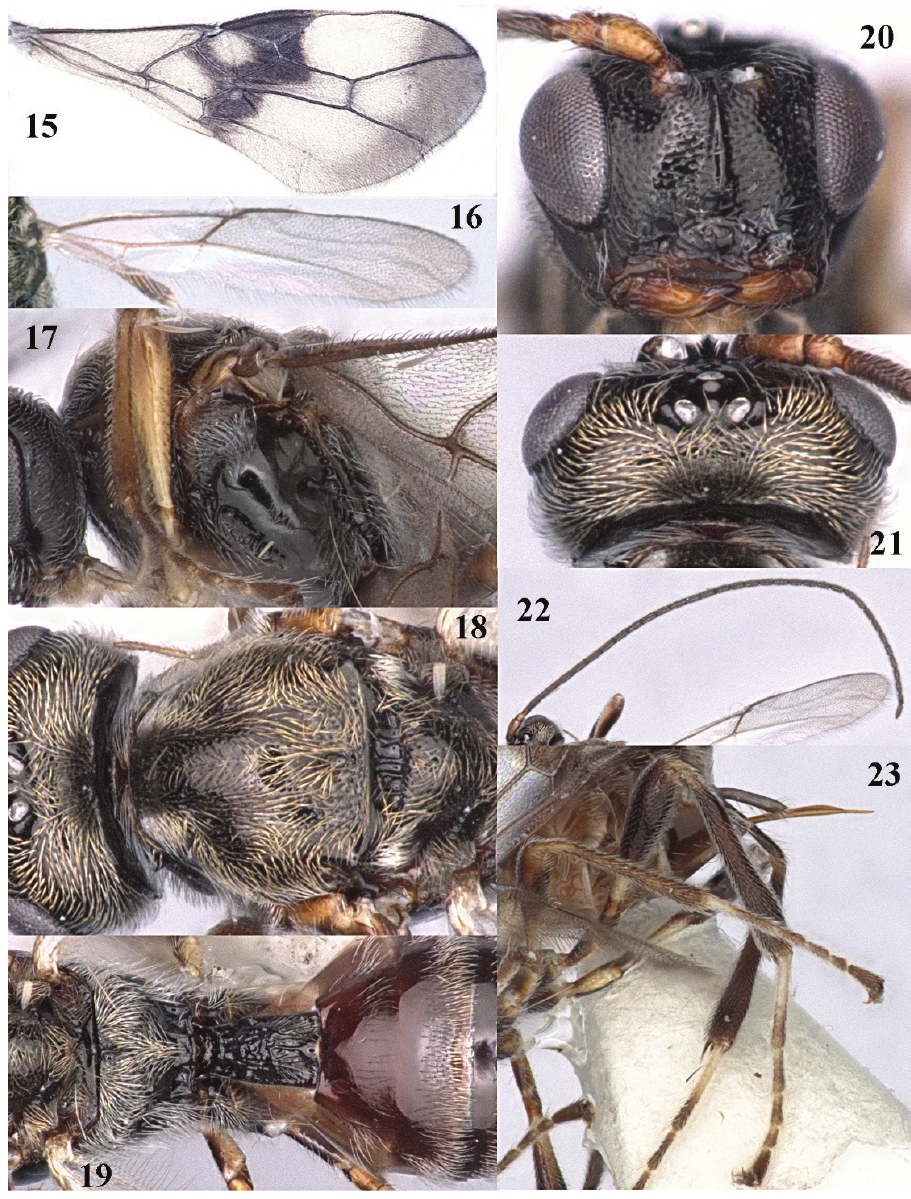
Figures 15–23. Xynobius chrysops sp. n., ♀ , holotype. 15 fore wing 16 hind wing 17 mesosoma, lateral aspect 18 head and mesosoma, dorsal aspect 19 propodeum and first-third metasomal tergites, dorsal aspect 20 head, anterior aspect 21 head, dorsal aspect 22 antenna 23 hind leg, lateral aspect. pterostigma; r long and connected with 3-SR by obtuse angle; r:3-SR:SR1 = 6:33:58; 2-SR:3-SR:r-m = 8:11:4; 1-M slightly curved and SR1 straight; m-cu distinctly post- furcal and straight; cu-a distinctly postfurcal and 1-CU1 slightly widened;1-CU1:2- CU1=1:18; first subdiscal cell closed and CU1b medium-sized; entire M+CU1